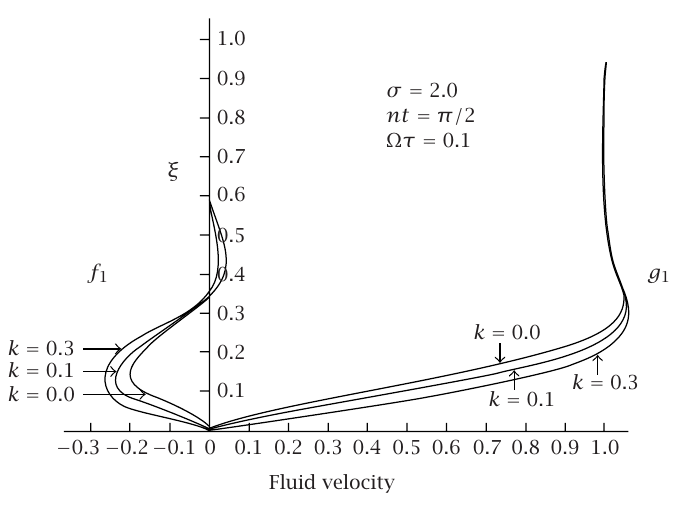
Figure 4.3 . Variations of f 1 and g 1 for different values of particle concentration k and for fixed values of nt and Ω τ when σ >